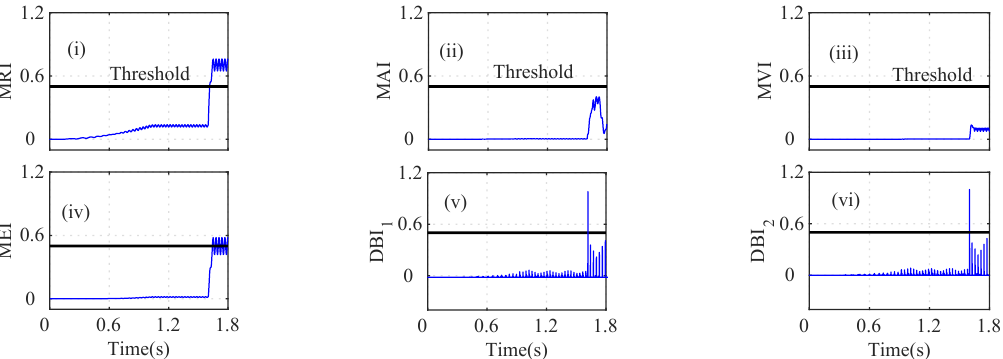
Figure 10. Analysis of residuals for V β using index-based method ((i) MRI, (ii) MAI, (iii) MVI, (iv) MEI, (v) DBI 1 and (vi) DBI 2 ) for incipient I α fault and abrupt V β fault at t = 1.256 s and t = 1.60 s.